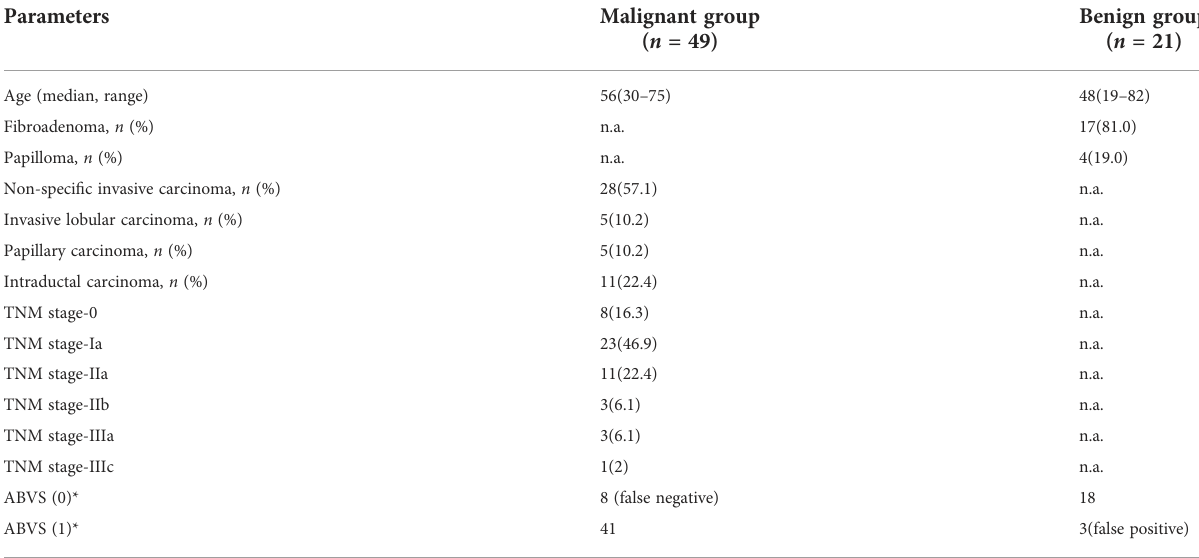
TABLE 1 Demographic and clinical pathological characteristics of study